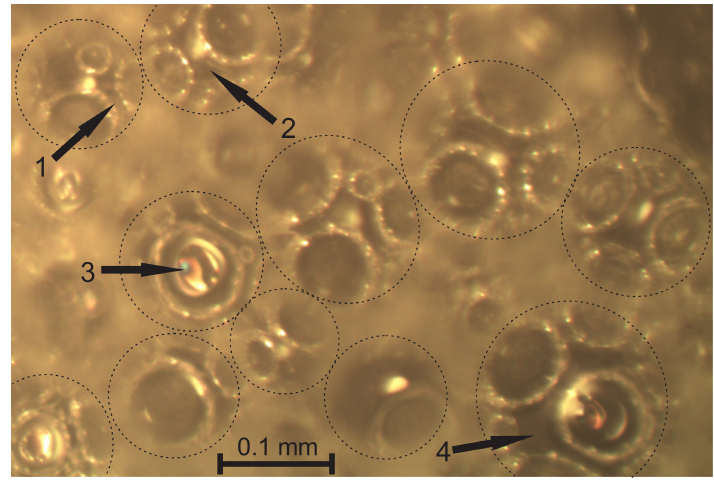
Figure 4. A through-cutting surface image of neat, medium-density PU foams, ρ f = 211 kg/m 3 (P1 = 16.5%), image plane X 1 = const.: 1, a strut, 2, a node, 3, a front view of a wall, and 4, an un-foamed